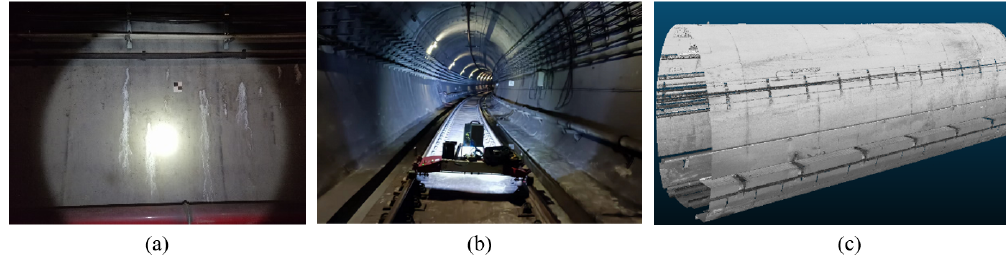
Figure 16. ( a ) Field target; ( b ) field working diagram; ( c ) partial laser point cloud data.